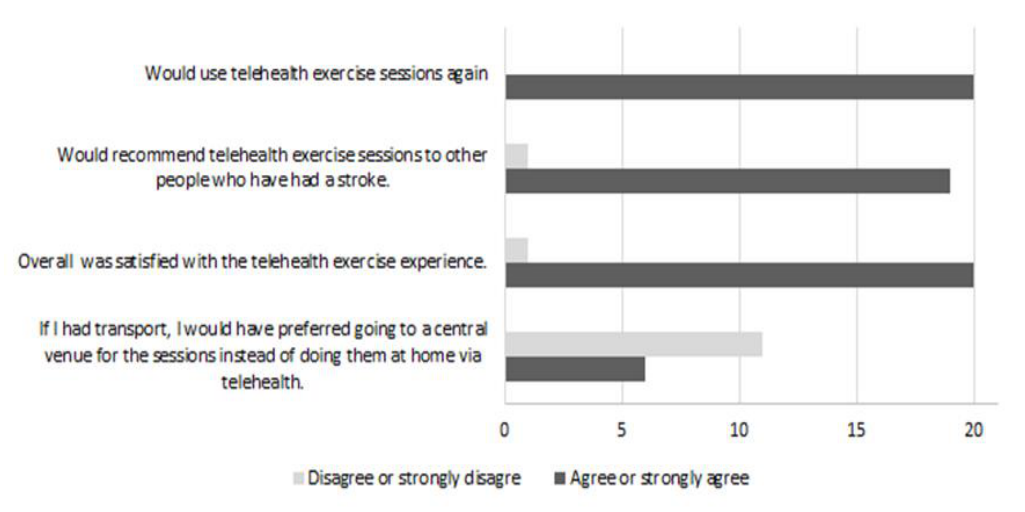
Figure 3 . Participant satisfaction with